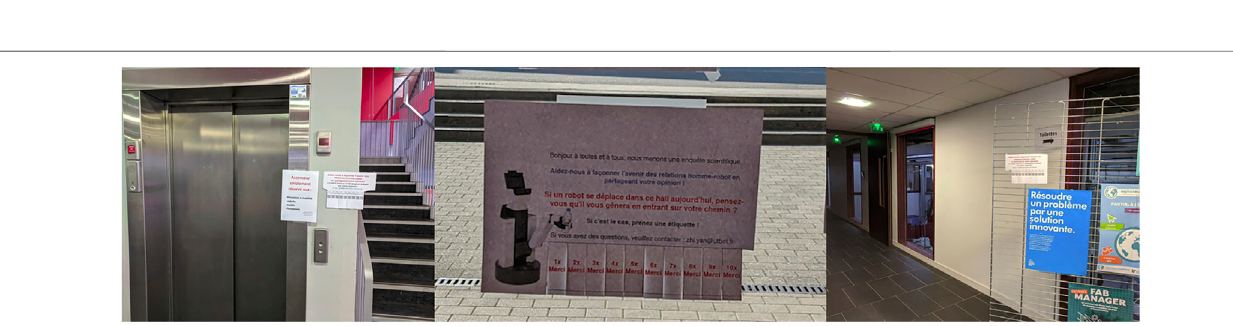
FIGURE 1 | Left: Toyota HSR robot including an Xtion RGB-D camera and a Hokuyo UST-20LX 2D LiDAR. Upper right: experimental environment. Lower right: occupancygridmapforrobotnavigation.Theredpointsarerepresentativeofthepositionsoftheremovabletags,andthebluepointsarethelocationsofthewaypoints.